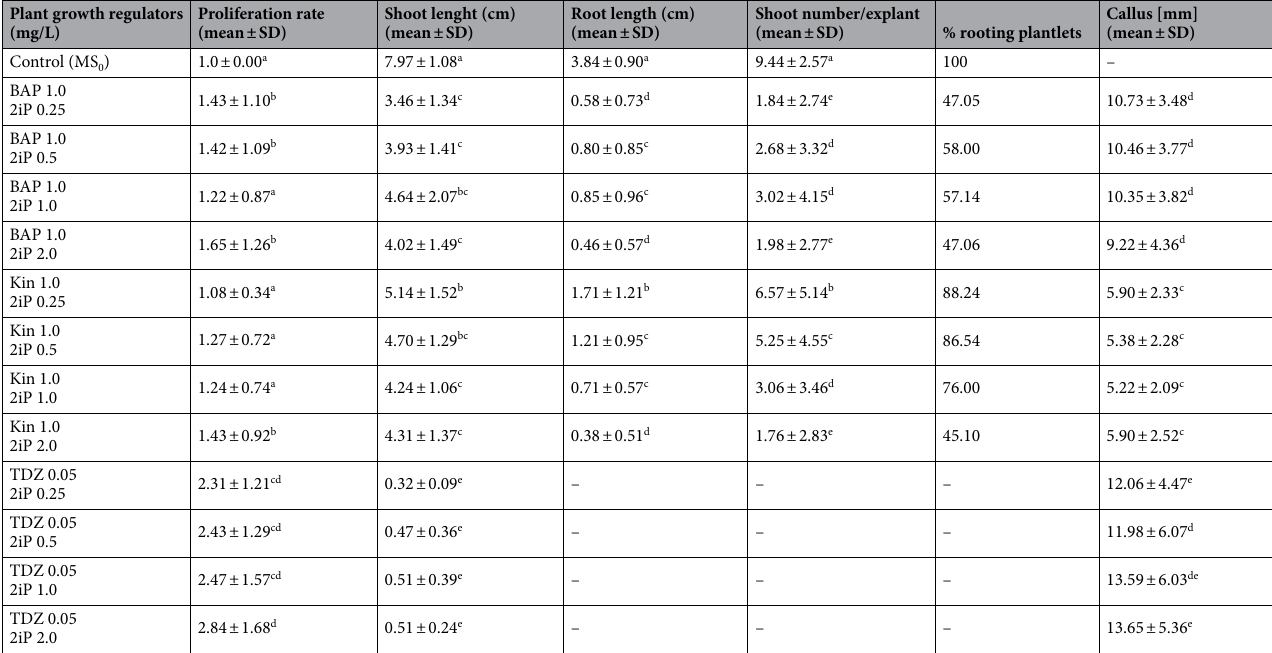
Table 5. Effect of 2iP supplementation in combination with BAP, Kin or TDZ on the development of P. amarus shoot culture. The results are the arithmetic means of ≥ 50 trials ± SD The values in each column marked with different letters (a, b, c …) indicate statistically significant differences (p < 0.05; Tukey’s RIR test).